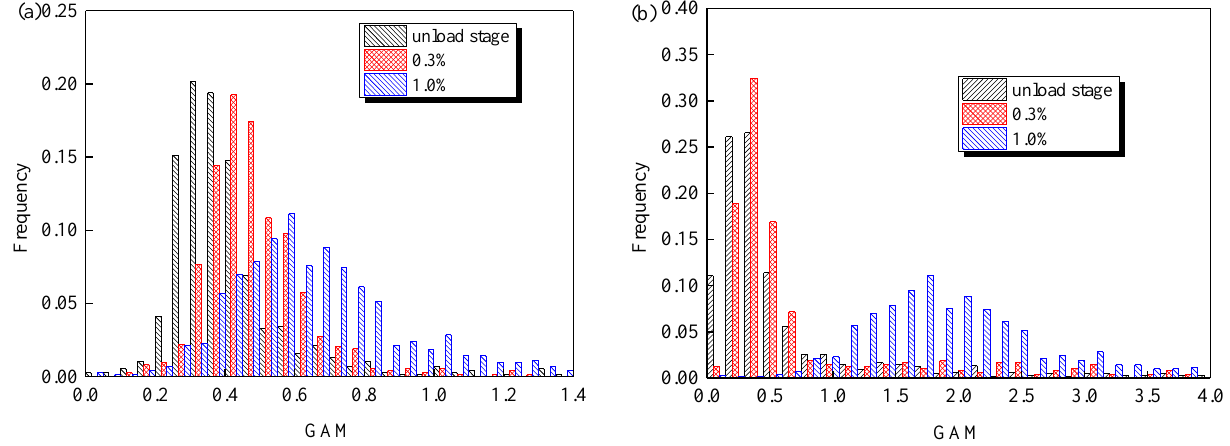
Figure 10. Statistics of GAM distribution within constituent phases after different strain amplitudes: ( a ) austenite and ( b ) ferrite.